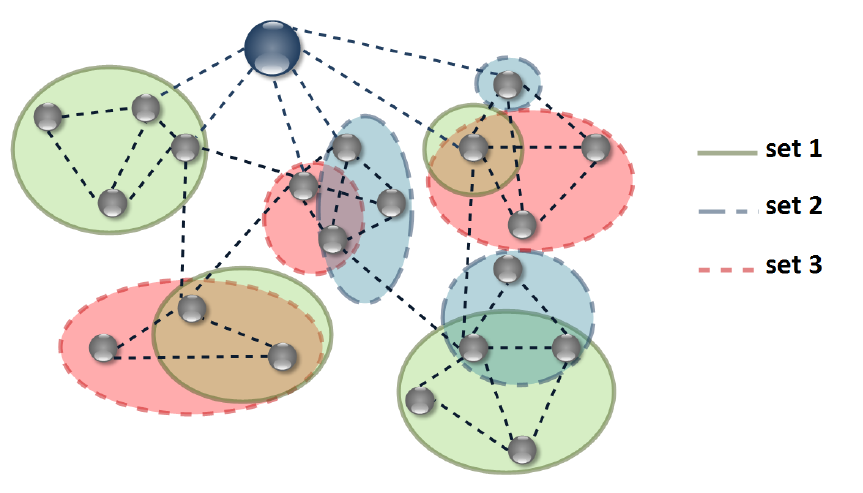
; nodes in set 3 might perform task f 2